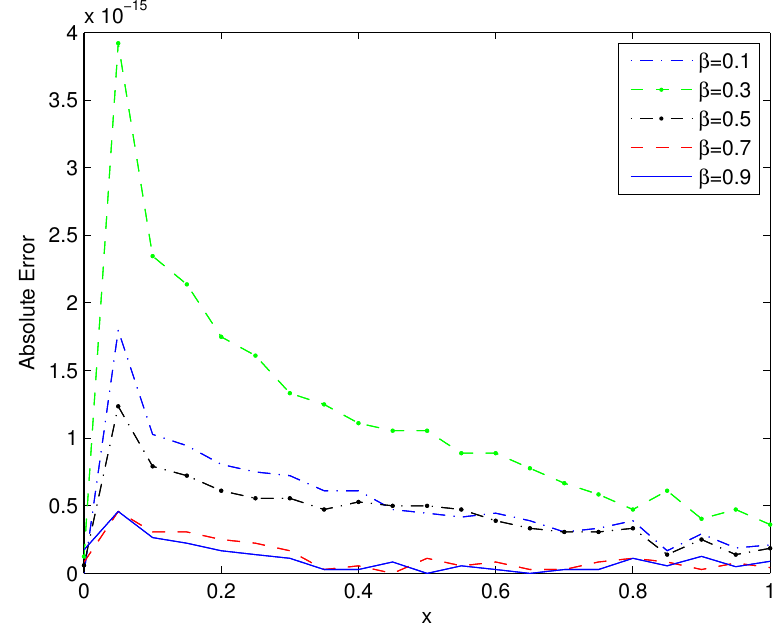
Figure 3. Absolute errors of Example 2 for QSOBWM with β =